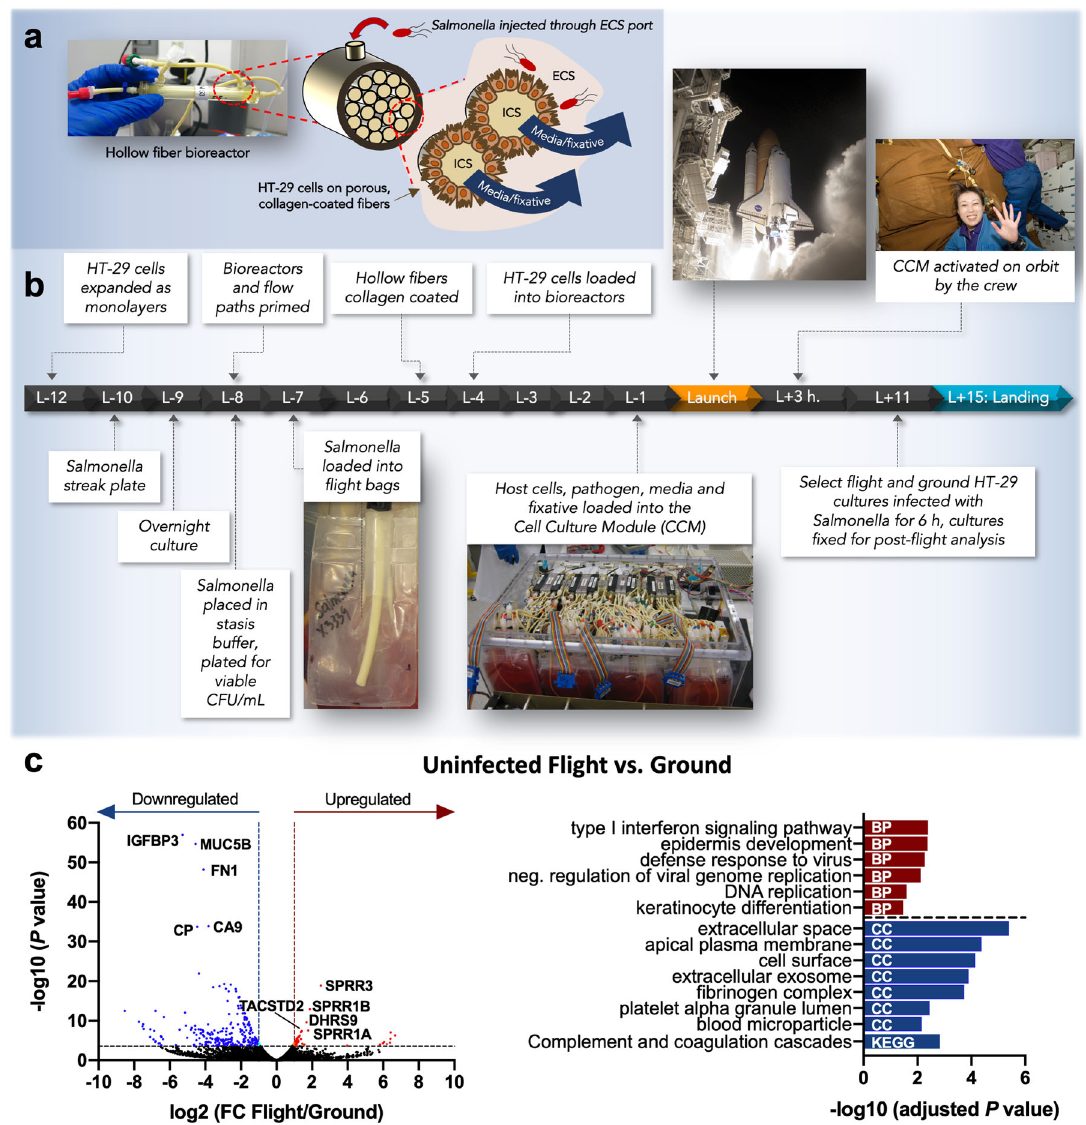
Fig. 1 STL-IMMUNE experimental design and impact of space fl ight on uninfected HT-29 transcriptional pro fi les. a Hollow fi ber bioreactor technology. Photo and cross-sectional schematic of the hollow fi ber bioreactors used in this study. Hollow fi bers had a pore size of 0.3 µm to retain bacteria within the extracapillary space (ECS) while still facilitating nutrient and gas exchange via diffusion as oxygenated media was perfused through the intracapillary space (ICS). b STL-IMMUNE experimental design. HT-29 cells and bacteria were prepared as shown (see “ Methods ” section for additional detail). Bioreactors, bacteria, and fi xative bags were integrated into the CCM hardware and launched aboard Space Shuttle Discovery mission STS-131. Crew members activated the CCM once on orbit. At mission elapsed day 11, cultures were infected with S . Typhimurium for 6 h and fi xed for post fl ight analysis. Launch and astronaut images: NASA [STS-131-S-036 (image is slightly cropped), S131E007206, and S131E007188]. c Space fl ight-induced transcriptional responses of HT-29 cells relative to ground controls. Left panel: volcano plot depicting differentially expressed genes (DEGs) between fl ight and ground control cultures ( fl ight/ground). Red: signi fi cantly upregulated genes according to a log 2 fold change in expression of at least ± 1 and FDR < 0.05. Blue: signi fi cantly downregulated genes. The top 5 signi fi cantly up and downregulated genes are labeled. Right panel: Analysis of upregulated (red) and downregulated (blue) transcripts revealed signi fi cantly enriched GO terms and KEGG pathways using DAVID. BP biological process, CC cellular component. The authors af fi rm that informed consent for publication of the images in Fig. 1 was